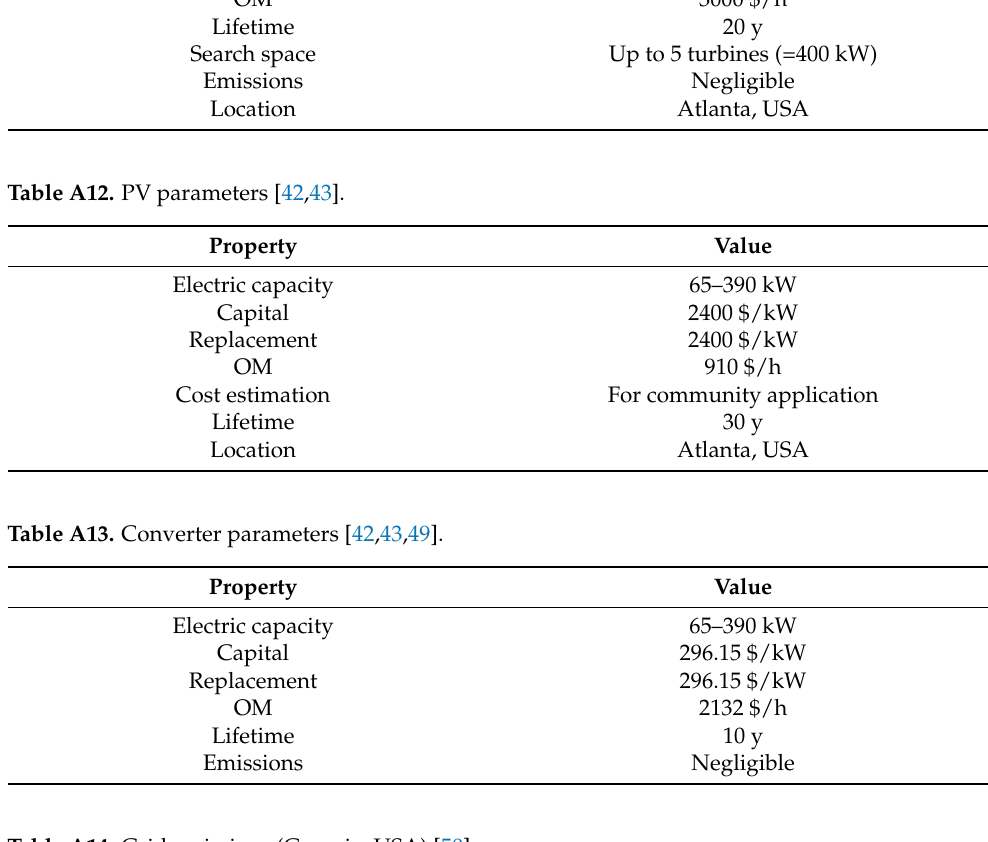
Table A14. Grid emissions (Georgia, USA)